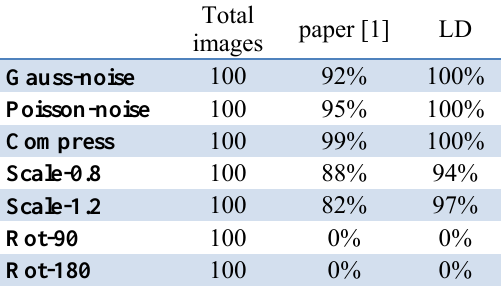
Table 4 Statistic result of large amount of images